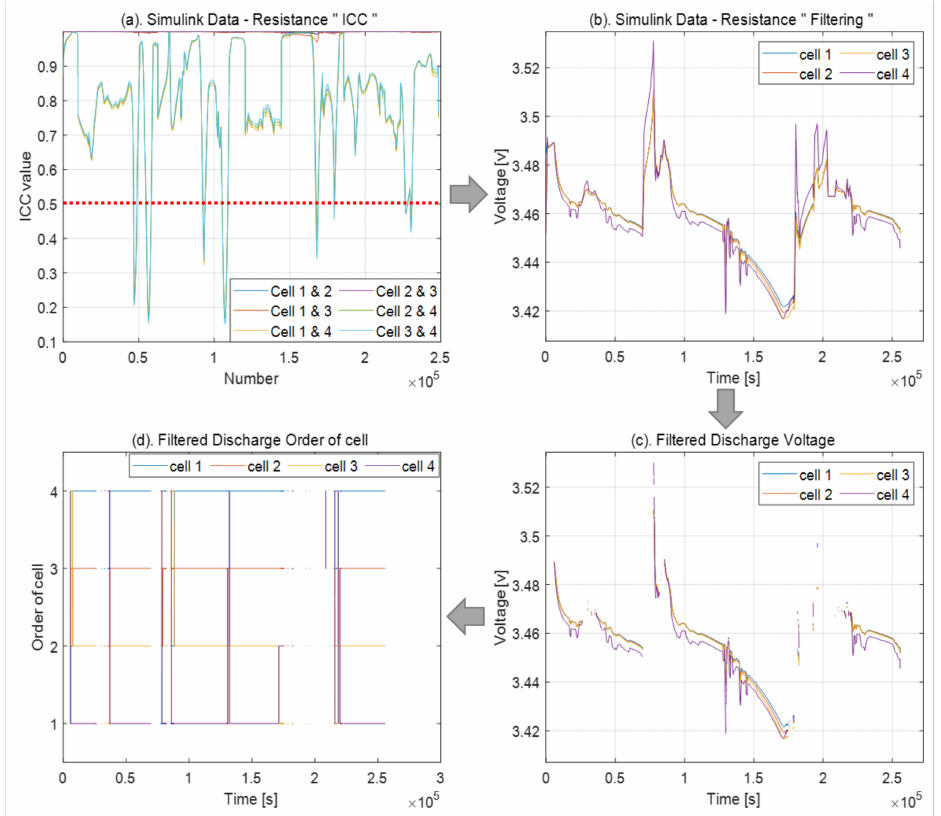
Figure 9. Simulink data with the resistance problem (( a ) ICC value, ( b ) filtering of voltage data, ( c ) cutting the discharge part in ( b ), and ( d ) order of cell voltages).